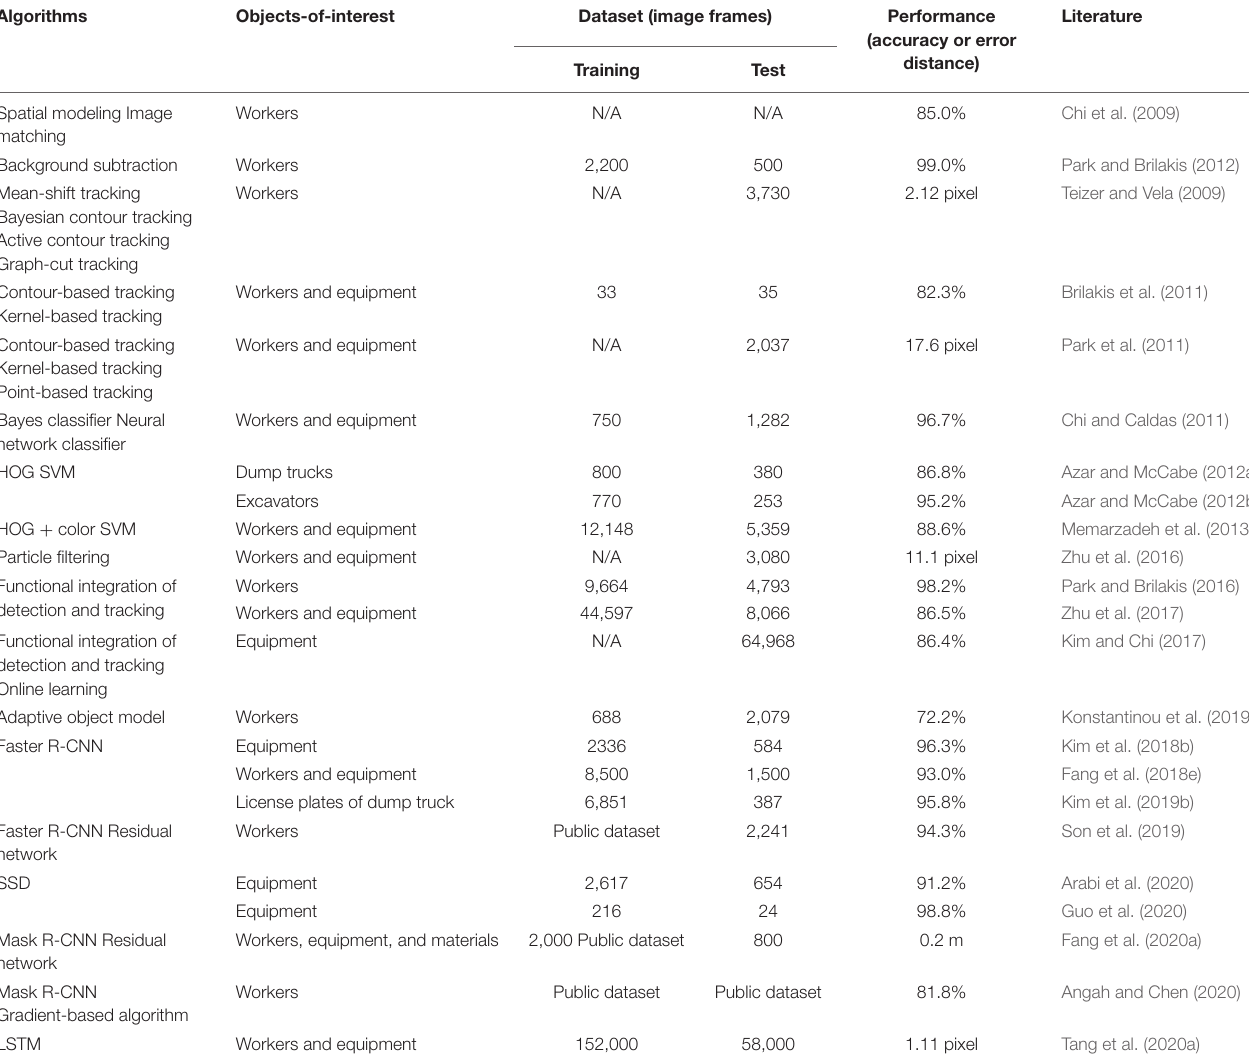
TABLE 1 | Summary of existing object detection and tracking algorithms.